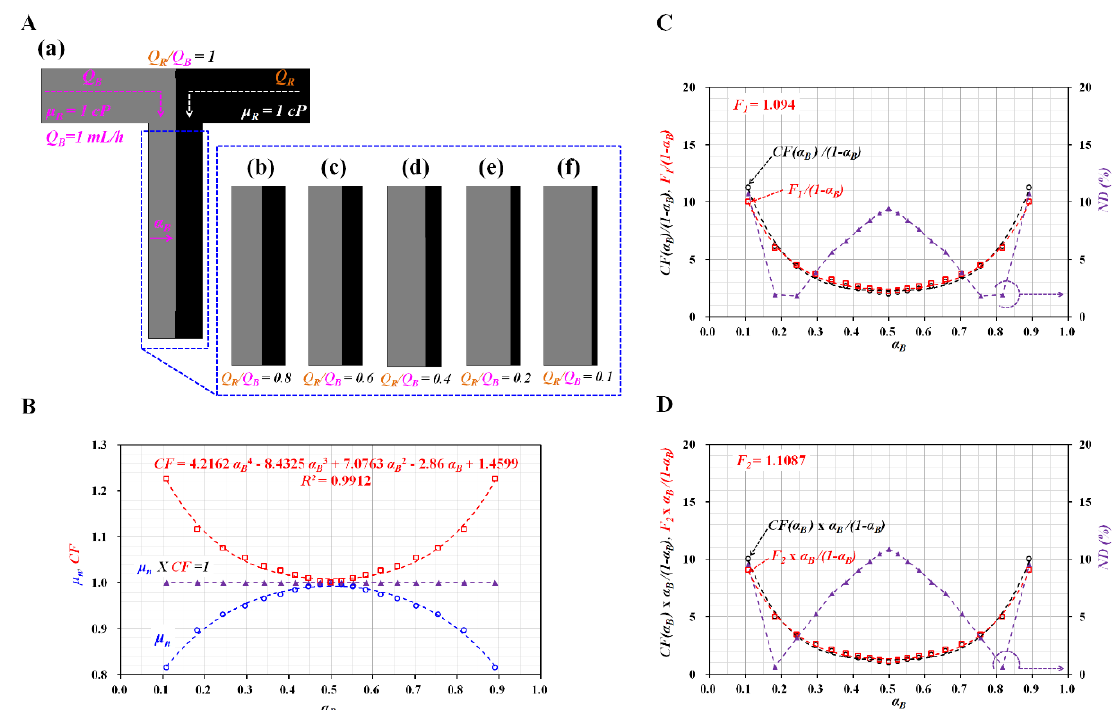
Figure 2. Estimation of correction factor ( CF ) and two approximate factors ( F 1 , F 2 ) with numerical simulation. ( A ) Variations of interface ( α B ) through numerical simulation with respect to flow-rate